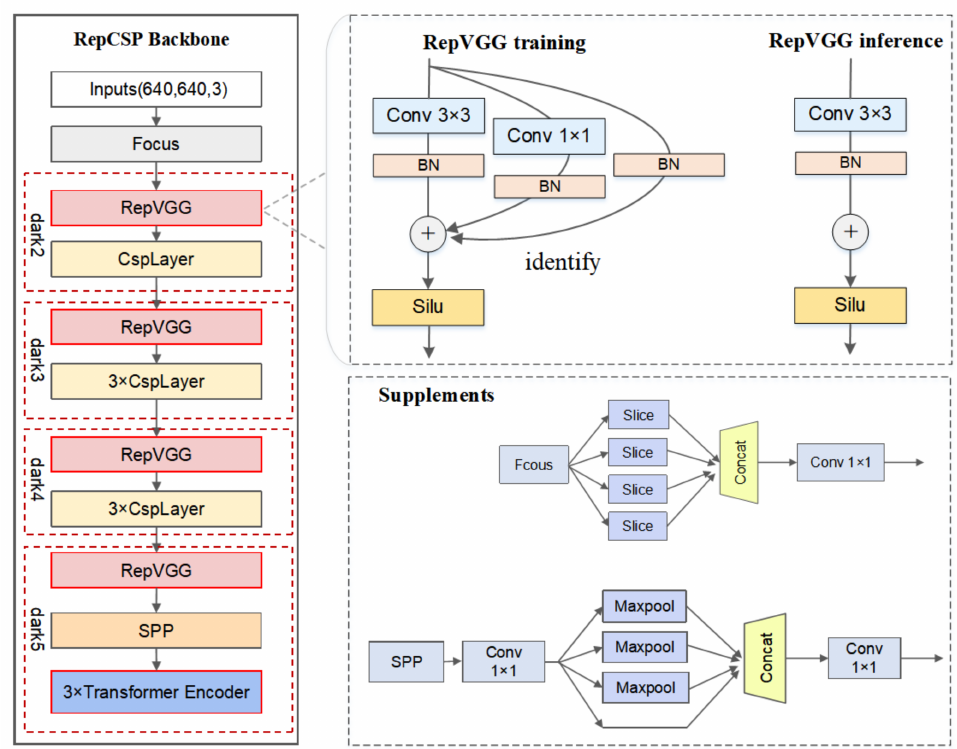
Figure 7. The structure of the RepCSP backbone and RepVGG block. RepVGG contains a multibranch structure in training time and a single-path structure in inference